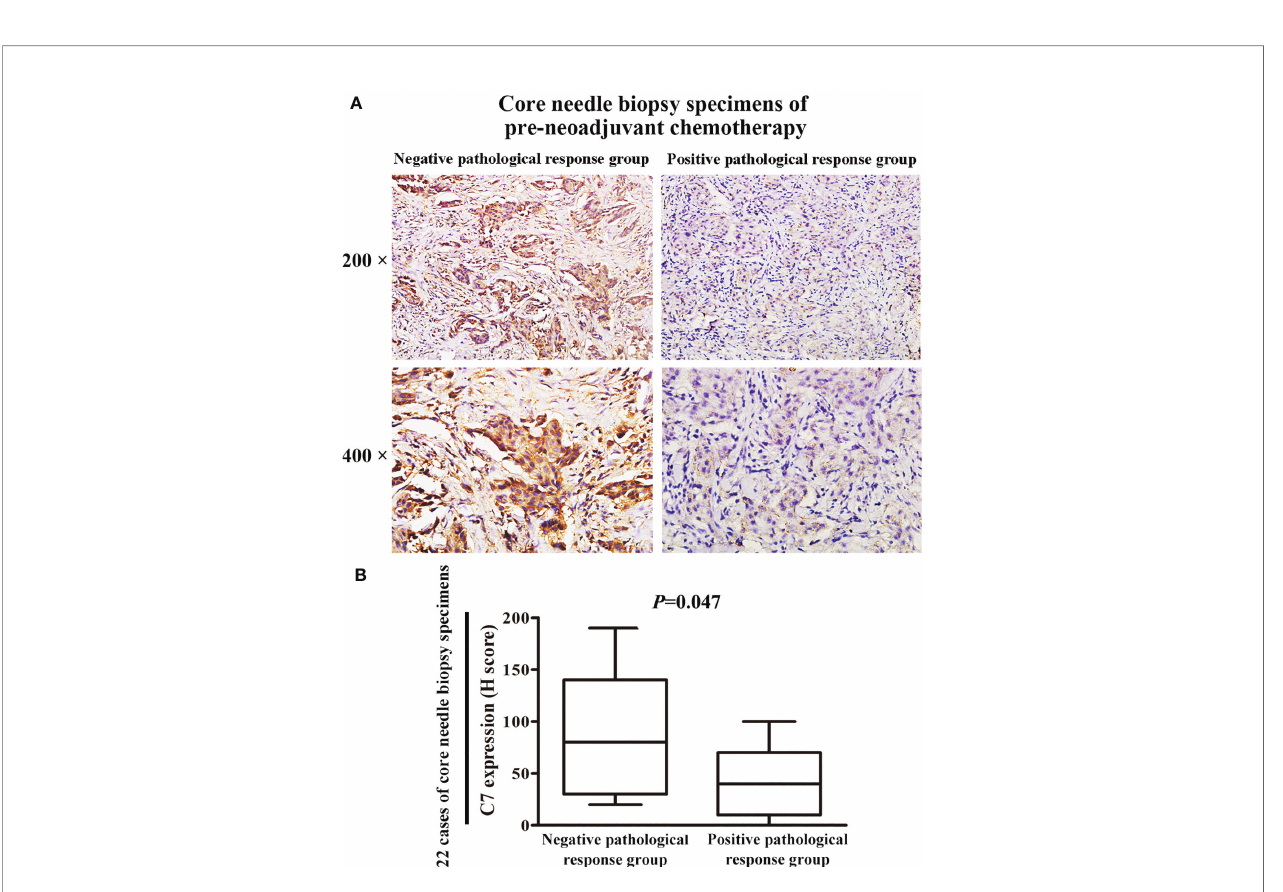
FIGURE 9 | Patients with high C7 expression were insensitive to TE neoadjuvant chemotherapy. (A) Representative immunohistochemical images of C7 expression in both positive and negative pathological response groups, respectively (magni fi cation 200× and 400×). (B) C7 expression in the negative pathological response group (n = 7) was higher than the positive pathological response group (n = 15, Mann-Whitney U test, P = 0.047).